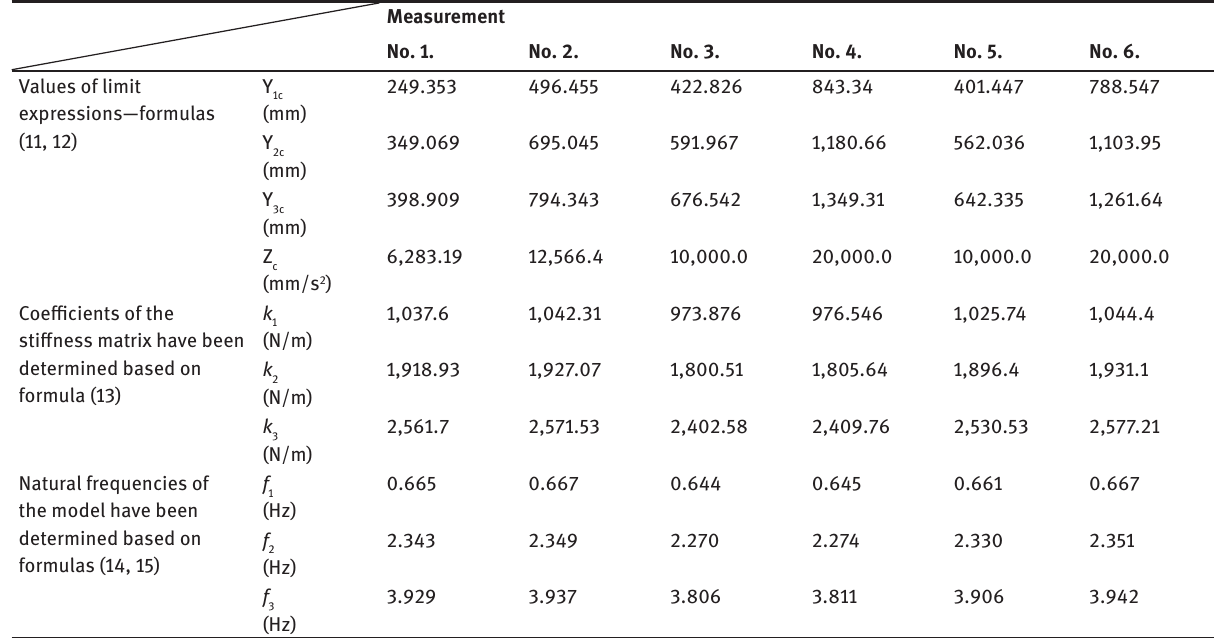
Table 2: Key results of experimental